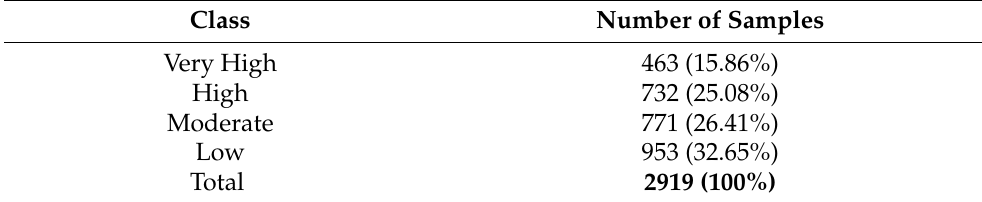
Table 5. Data distribution in the dataset according to each fatigue